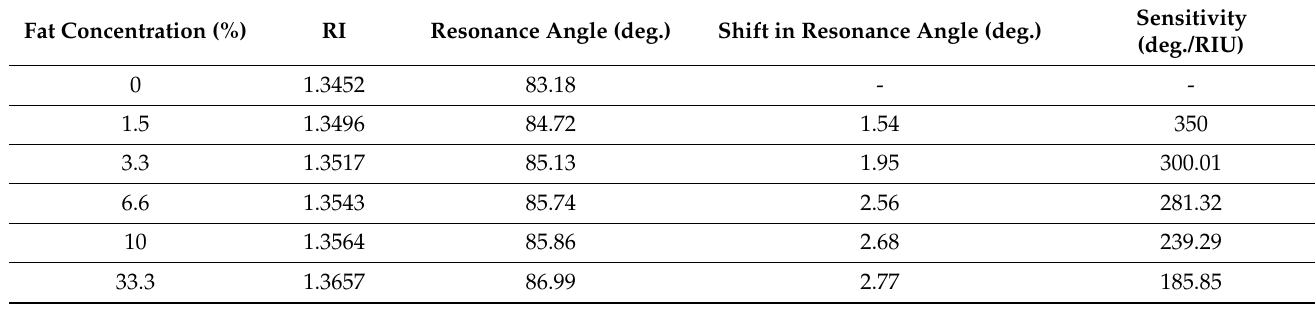
Table 3. Fat concentration with the corresponding RI, shift in resonance angle, and sensitivity.